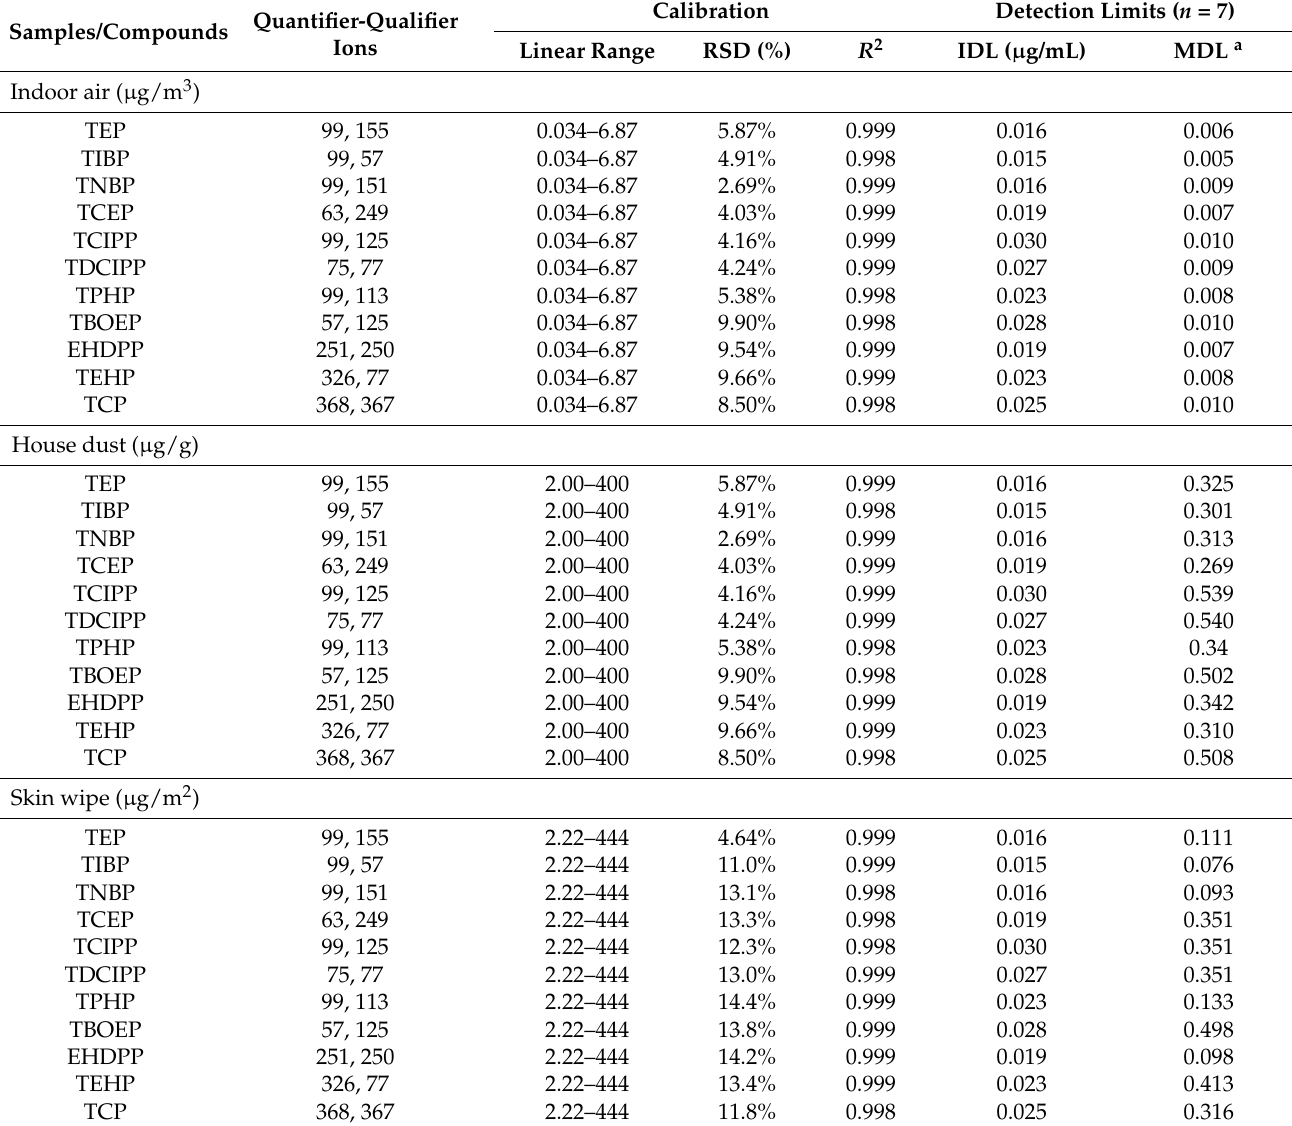
Table 1. Optimized GC/MS parameters, calibration and detection limits for 11